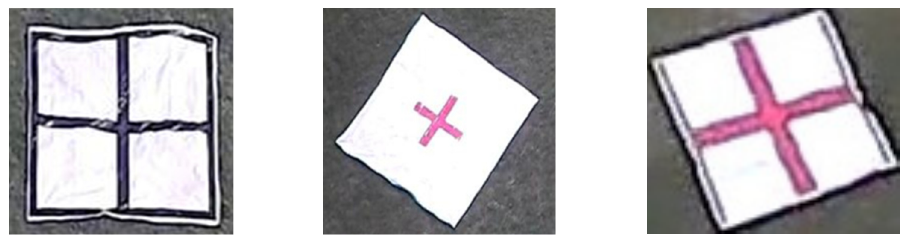
Figure 17. Target